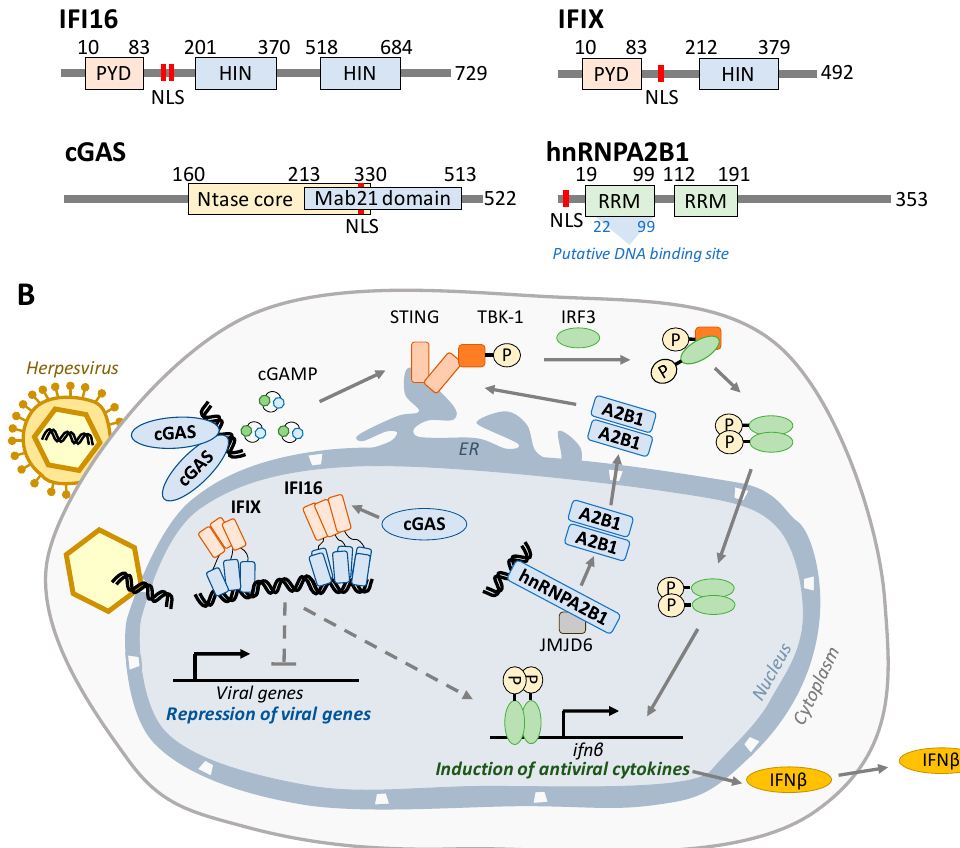
Figure 1. Nuclear DNA sensors bind to viral DNA and activate antiviral cytokine signaling. ( A ) Domain maps for each nuclear DNA sensor. IFI16 and IFIX belong to the PYHIN family of proteins and each contain an N-terminal pyrin domain that mediates protein interactions and one or two HIN-200 domains that bind dsDNA in a sequence-independent manner. cGAS consists of overlapping Ntase core (cGAMP production) and Mab21 (DNA binding) domains. hnRNPA2B1 possesses two RNA recognition motifs, the first of which has been proposed to also contain the DNA binding site. Each protein contains a nuclear localization signal (red bars). ( B ) Model for the intrinsic and innate immune activity of IFI16, IFIX, cGAS, and hnRNPA2B1. During infection, IFI16 and IFIX bind viral DNA entering the nucleus through a nuclear pore complex. After binding to viral DNA via their HIN domains (blue), these proteins each form homo-oligomers mediated by the PYD in order to build antiviral signaling sca ff olds necessary for the repression of viral transcription and induction of IFNß. cGAS was shown to stabilize nuclear IFI16 levels during HSV-1 infection to promote immune signaling. In the cytoplasm, cGAS binds to foreign DNA and produces cGAMP, which in turn activates the STING–TBK1–IRF3 signaling axis to induce IFNß. hnRNPA2B1 binds viral DNA and is then demethylated by JMJD6. This is required for hnRNPA2B1 dimerization and subsequent translocation into the cytosol, where it activates the STING–TBK1–IRF3 axis. In each case, IFNß protein is secreted from the cell in order to communicate with and initiate antiviral programs in neighboring